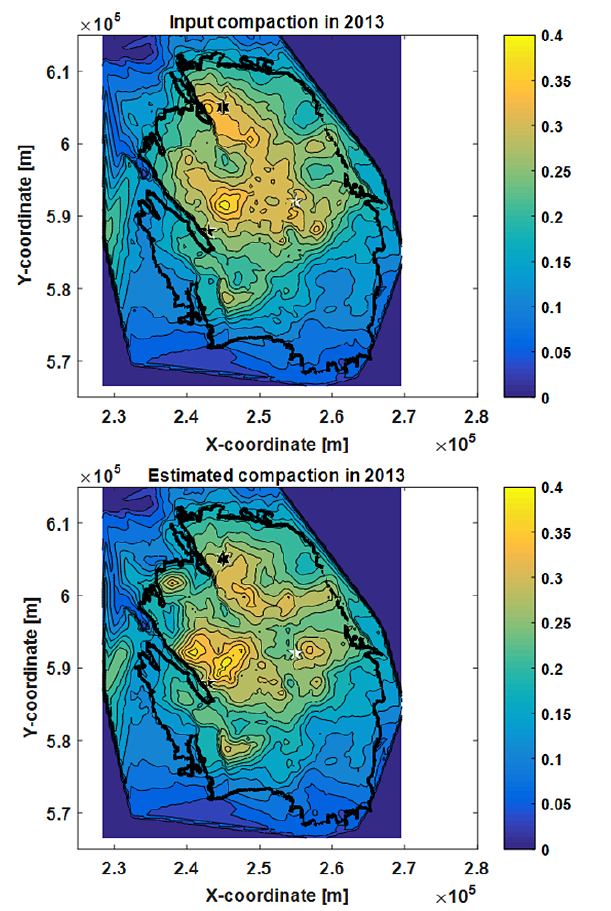
Figure 2. Prior compaction fields and estimated compaction fields in